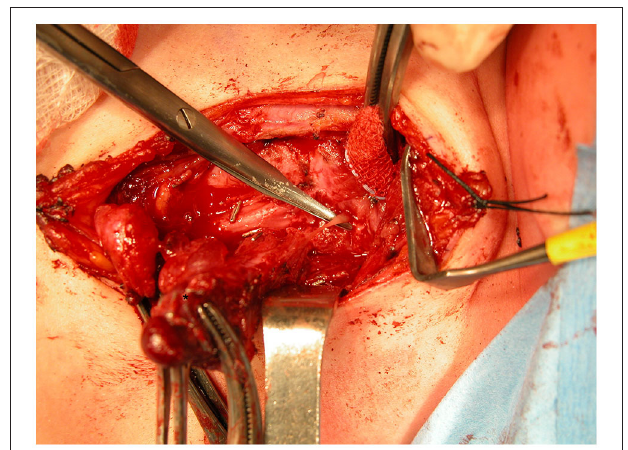
FIGURE 3 | Visualizing the tract of the sinus. Clamps are holding the involved left thyroid lobe (asterisk). Arrowhead indicates the spared left recurrent laryngeal